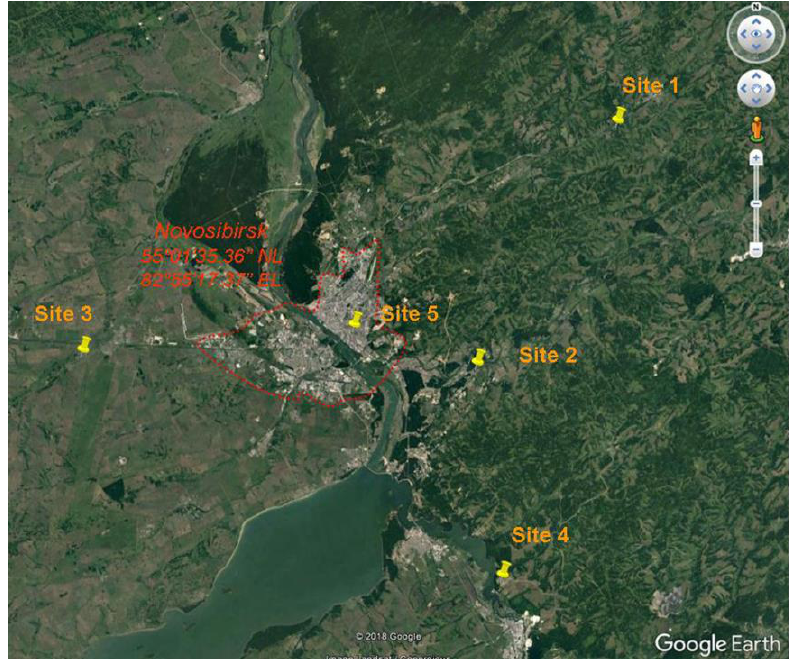
Figure 1. The location of the study sites.